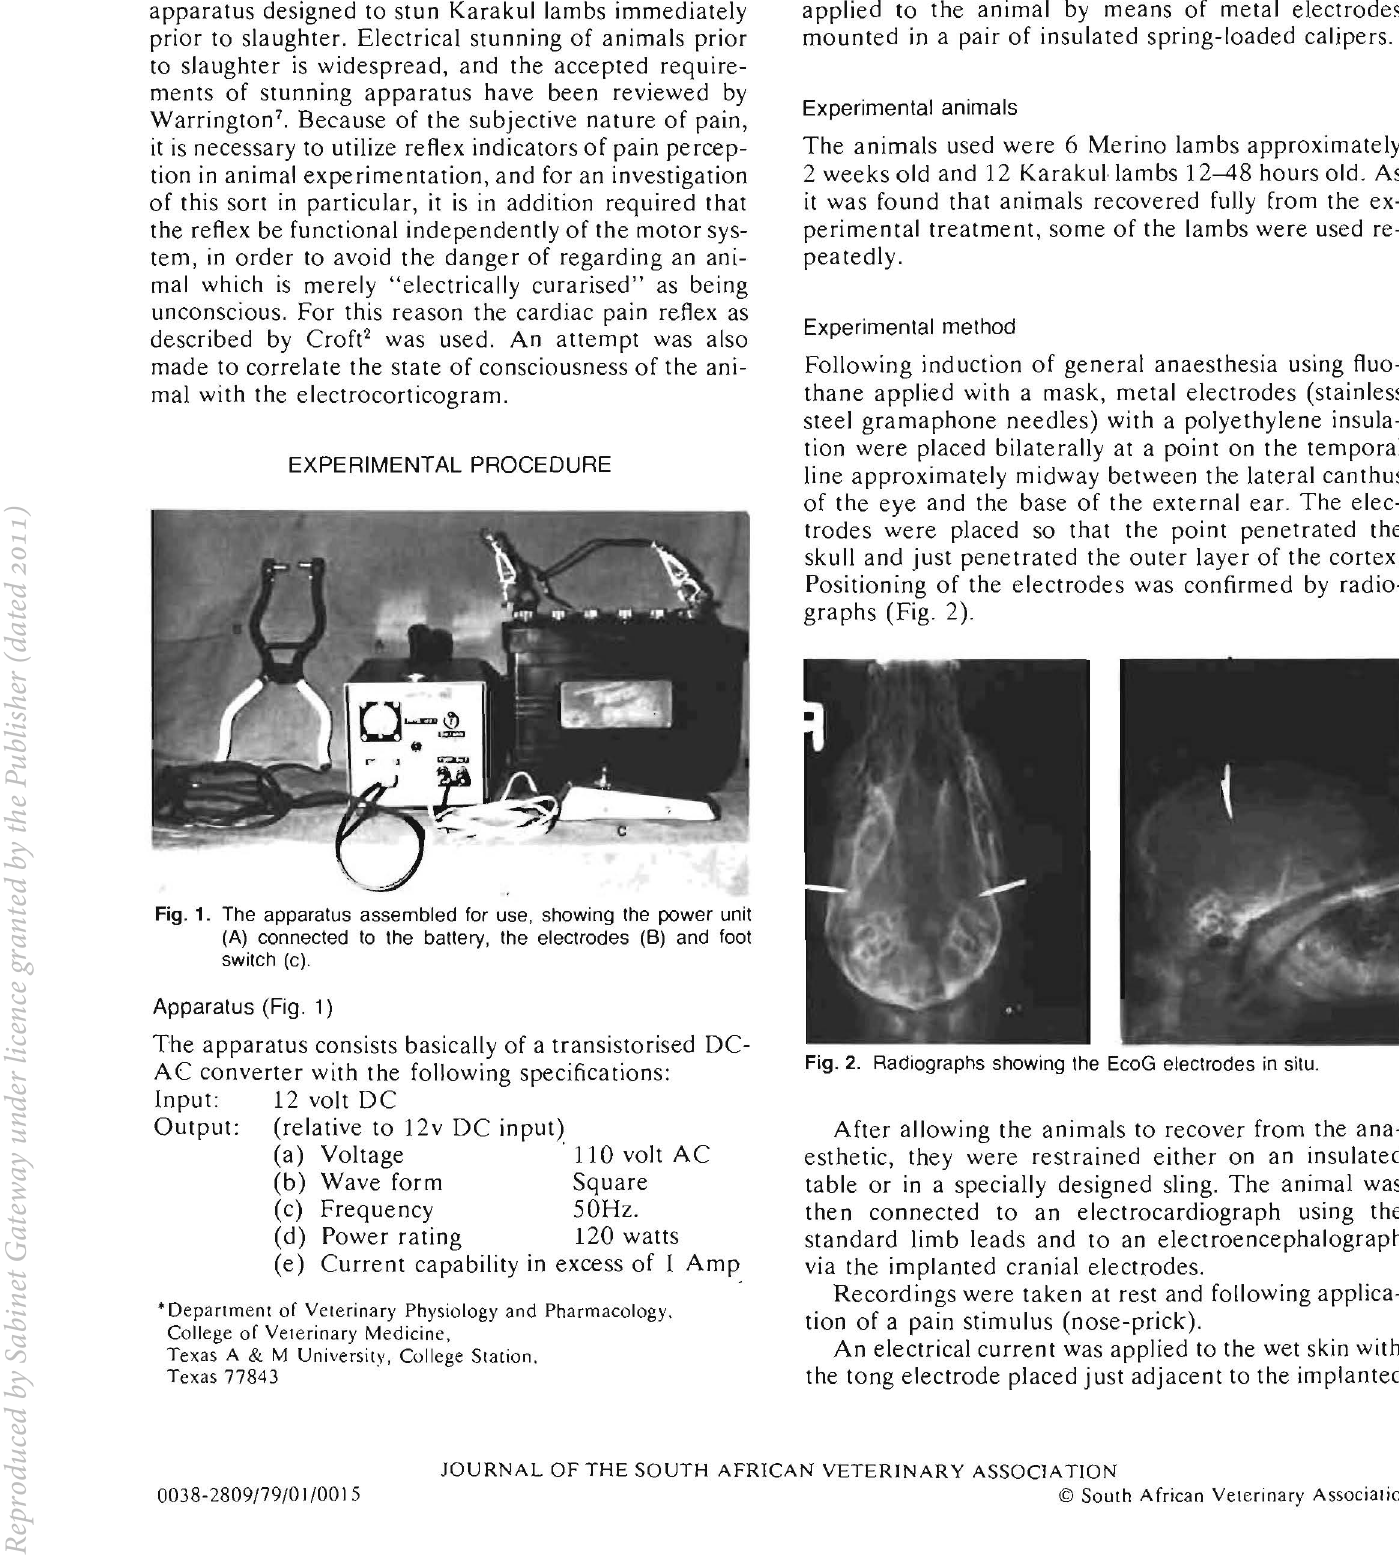
Fig. 2. Radiographs showing the EcoG electrodes in